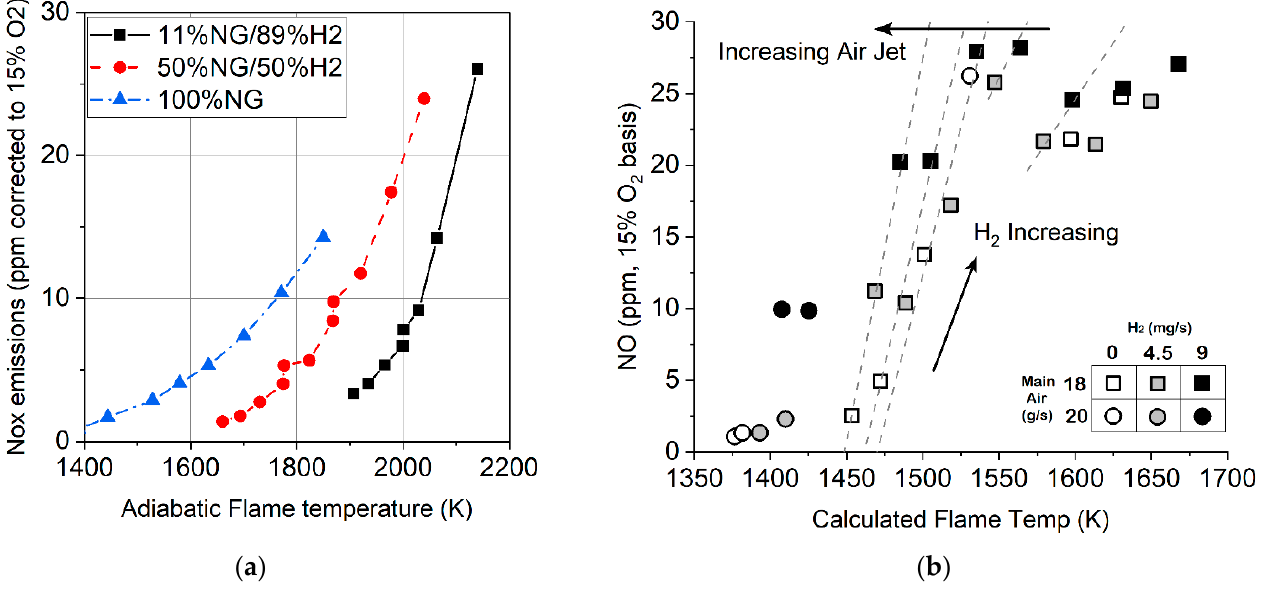
Figure 20. Dependence of NOx emissions on the adiabatic flame temperature for different volume proportions of hydrogen–natural gas [4,47] ( a ) for methane–hydrogen mixtures with constant methane consumption; ( b ) for methane–hydrogen mixtures with different methane consumptions.